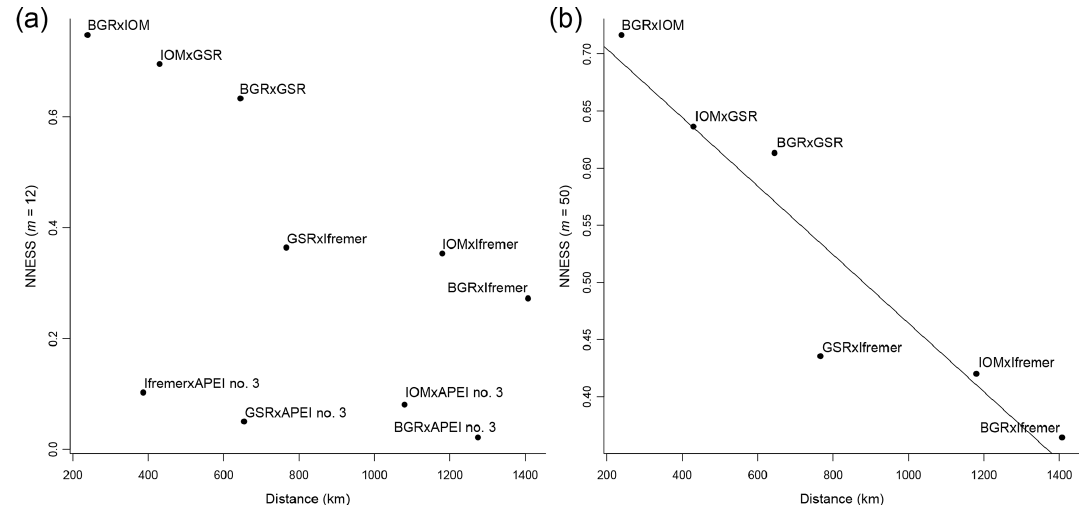
Figure 8. Distance decay of New Normalized Expected Species Shared (NNESS) between BGR, IOM, GSR, Ifremer, and APEI no. 3 using m = 12 (a) and between BGR, IOM, GSR, and Ifremer using m = 50 with regression ( y intercept: 0.7642, slope: − 0 . 0002999) (b)